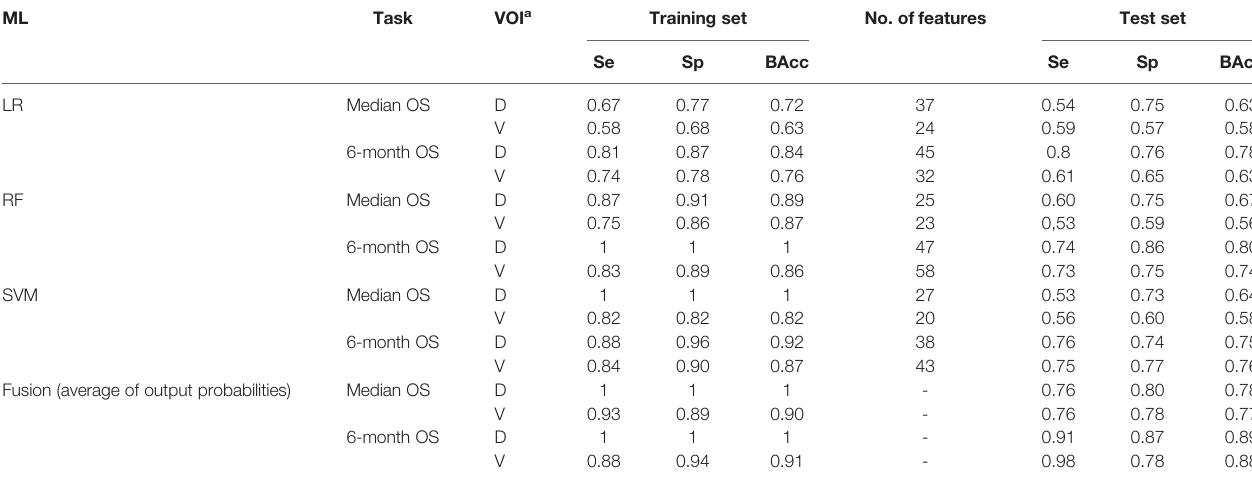
TABLE 2 | Performance comparison of the ML techniques using either features from the delineated tumor (D) or from the rough VOI (V), in addition to the available clinical factors. ML Task VOI a Training set No. of features